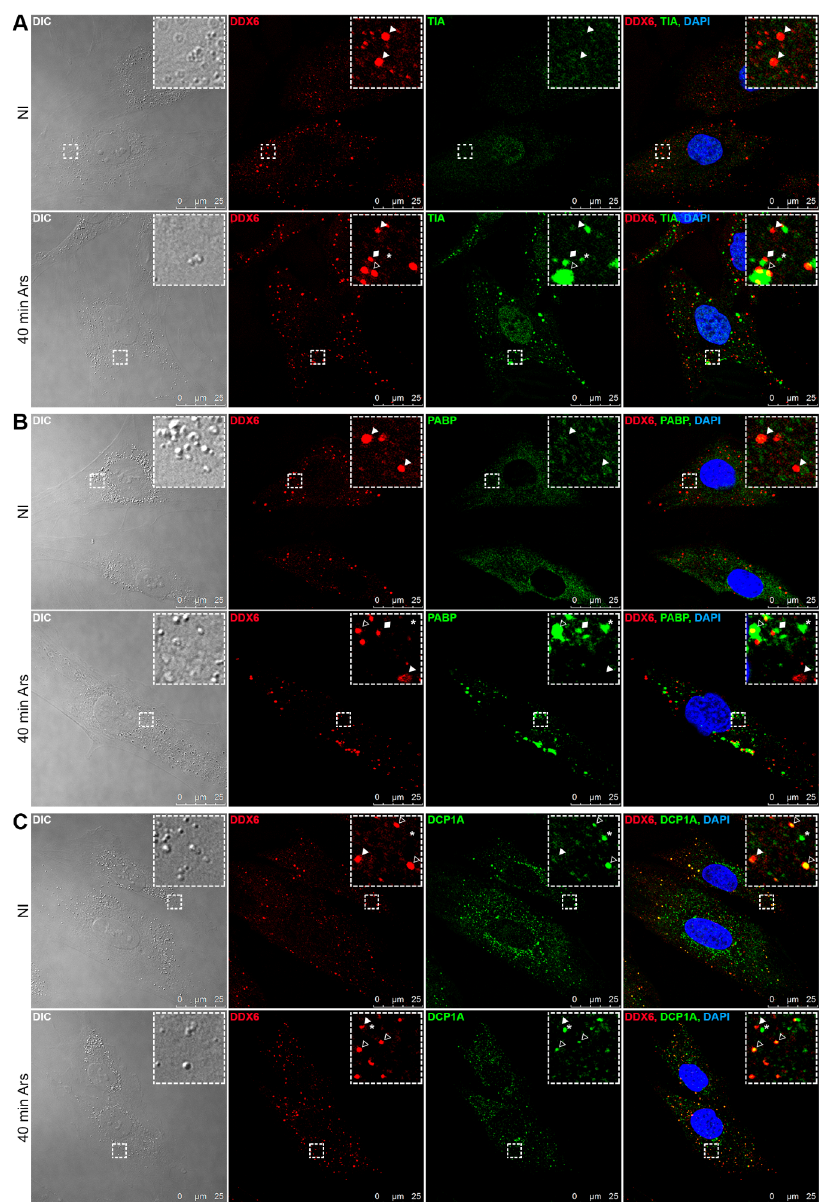
Figure 2. Localization of DDX6 and stress granule (SG) or P-body proteins in the hASCs not induced by stress and after stress induction. The distribution of the proteins in the hASCs maintained in the noninduction control medium (NI) and hASCs in medium treated with sodium arsenite (40 min Ars) was analyzed by immunofluorescence and confocal microscopy. ( A ) In the NI hASCs, TIA1 was found mainly in the cell nucleus. After stress induction, TIA1 migrated to the cytoplasm and aggregated in the SGs that partially colocalized with DDX6 granules. ( B ) PABP was found in the cell cytoplasm. After stress induction, PABP was also concentrated in the SGs that partially colocalized with DDX6 granules. ( C ) Under both the NI and stress conditions, DDX6 partially colocalized with DCP1A. Notably, under both conditions, granules containing only DDX6 or only DCP1A were found. White arrows: granules that contained only DDX6; asterisks: granules that contained only TIA1 ( A ), PABP ( B ) or DCP1A ( C ); hollow arrows: granules containing both DDX6 and TIA1 ( A ), PABP ( B ) or DCP1A ( C ); and rhombus: granules with juxtaposed DDX6 and TIA1 ( A ) or PABP ( B ). Nuclei were stained with